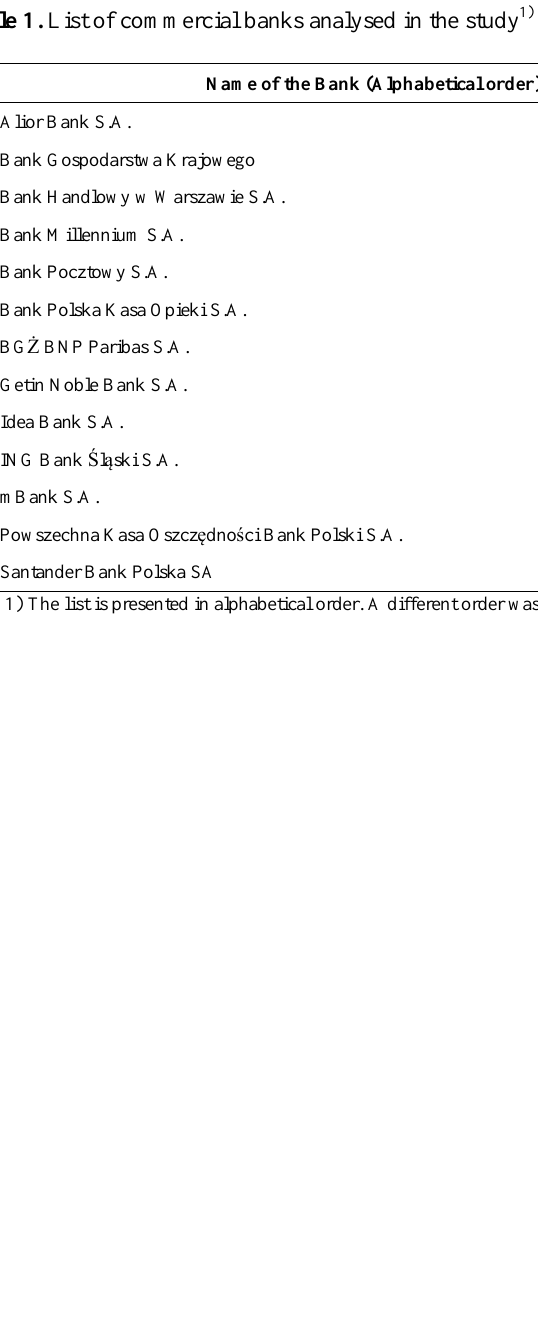
Table 1. List of commercial banks analysed in the study 1)